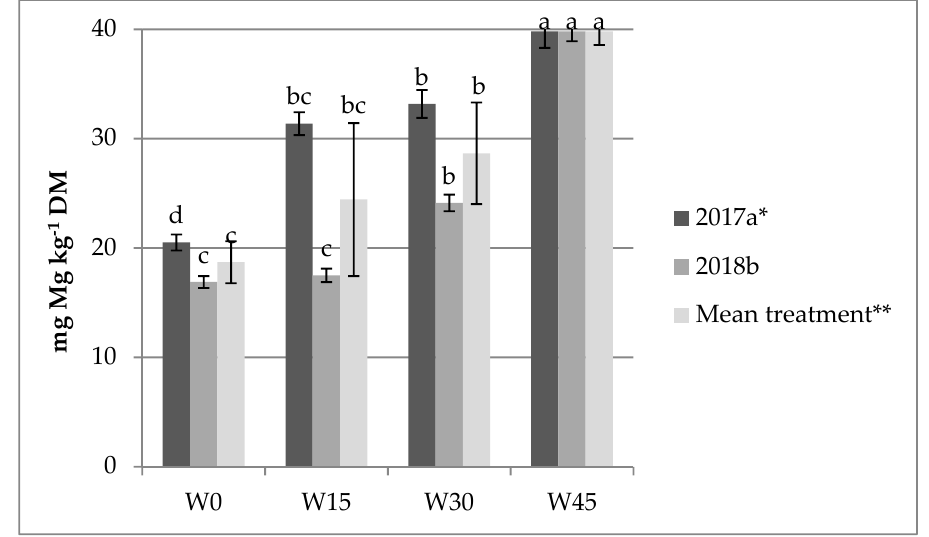
Figure 10. Available Mg content in soil. W0—the control with no stillage treatment, W15—15 m 3 of stillage per hectare, W30—30 m 3 of stillage per hectare, W45—45 m 3 of stillage per hectare. * means of years regardless of treatments; ** means of treatments regardless of years. The same letter means not significantly di ff